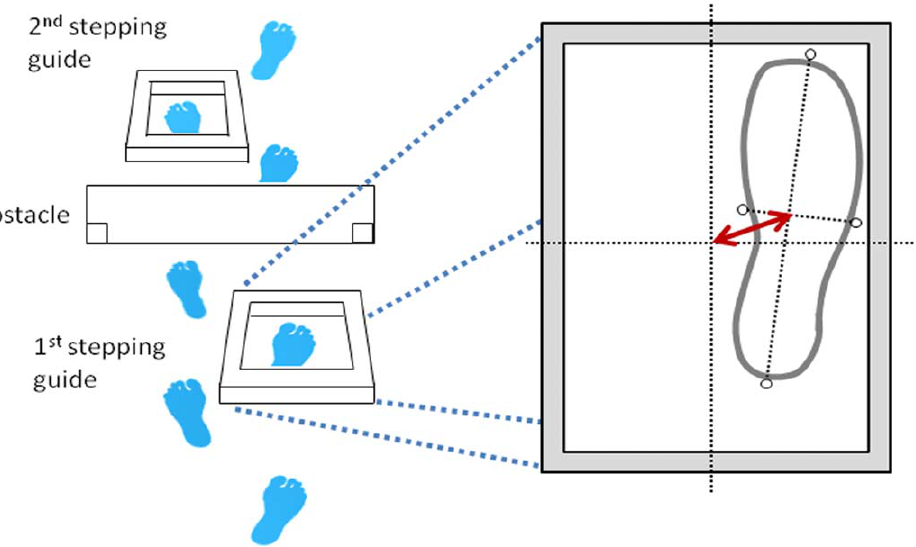
Figure 1. Experimental protocol. The stepping constraints are illustrated from the perspective of P8 before she started walking at the start of each trial. Typically P8 would require 5–7 steps between initiating gait at the starting position and stepping in the first stepping guide. The centres of both the foot and stepping guide were calculated as the intercept between the medio-lateral and anterior-posterior coordinates of each, as illustrated by the black dotted lines. The red arrow represents the absolute error of foot placement in the stepping guide, calculated as the distance between the central positions of the foot and stepping guide. doi:10.1371/journal.pone.0049765.g001 PLOS ONE |